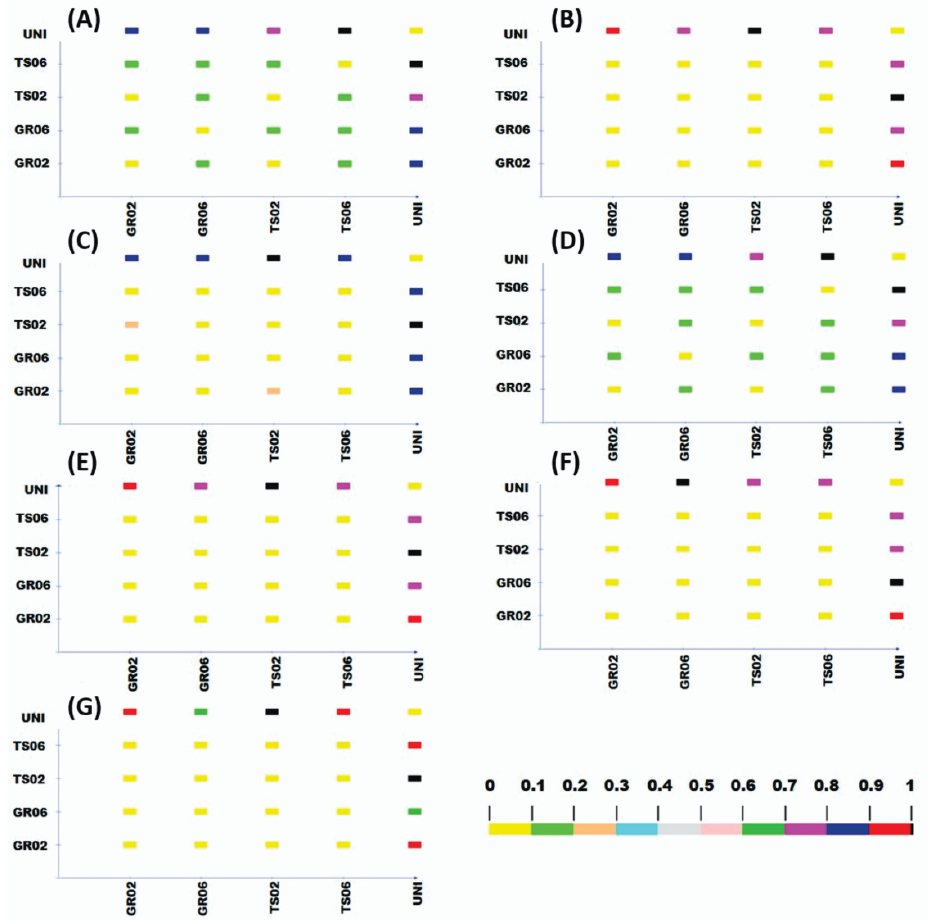
Figure 3. Dissimilarity between treatments with different inoculation methods and doses of As- pergillus niger FS1 in vegetables: ( A ) lettuce, ( B ) melon, ( C ) pepper, ( D ) scarlet eggplant, ( E ) water- melon, ( F ) tomato, and ( G ) kale. Color scale determined by Tocher optimization method varies from no dissimilarity (yellow) to complete dissimilarity (black) between each pair of treatments. GR02 and GR06: in-furrow granular application at 10 2 and 10 6 conidia plant − 1 , respectively; TS02 and TS06: seed treatment at 10 2 and 10 6 conidia plant − 1 , respectively; UNI: uninoculated control. Table 3. Relative importance (%) of measured variables on the dissimilarity between treatments for each vegetable